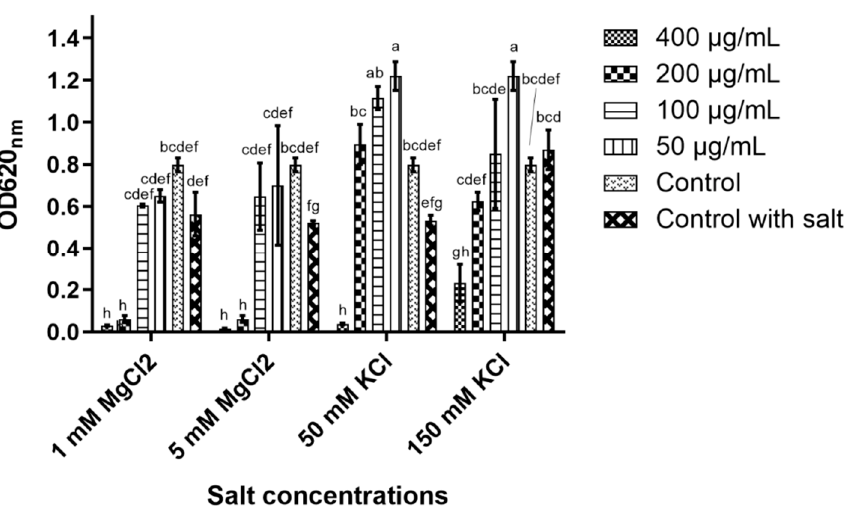
Figure 3. The effect of different salt concentrations (MgCl 2 and KCl) on the antiyeast activity of the peptide. ANOVA analysis was performed to determine the significant differences between the peptide’s inhibitory activity in these salt concentrations (at various concentrations of the peptide). The values containing different letters vary statistically (a–h).